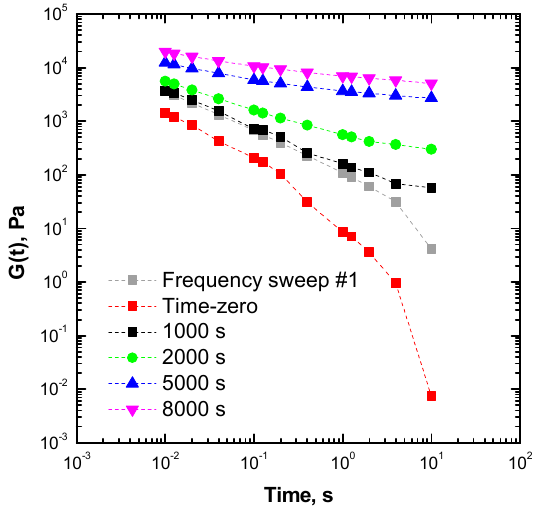
Figure 5. Stress relaxation curves for structural modifications of ENR25 at 180 °C.